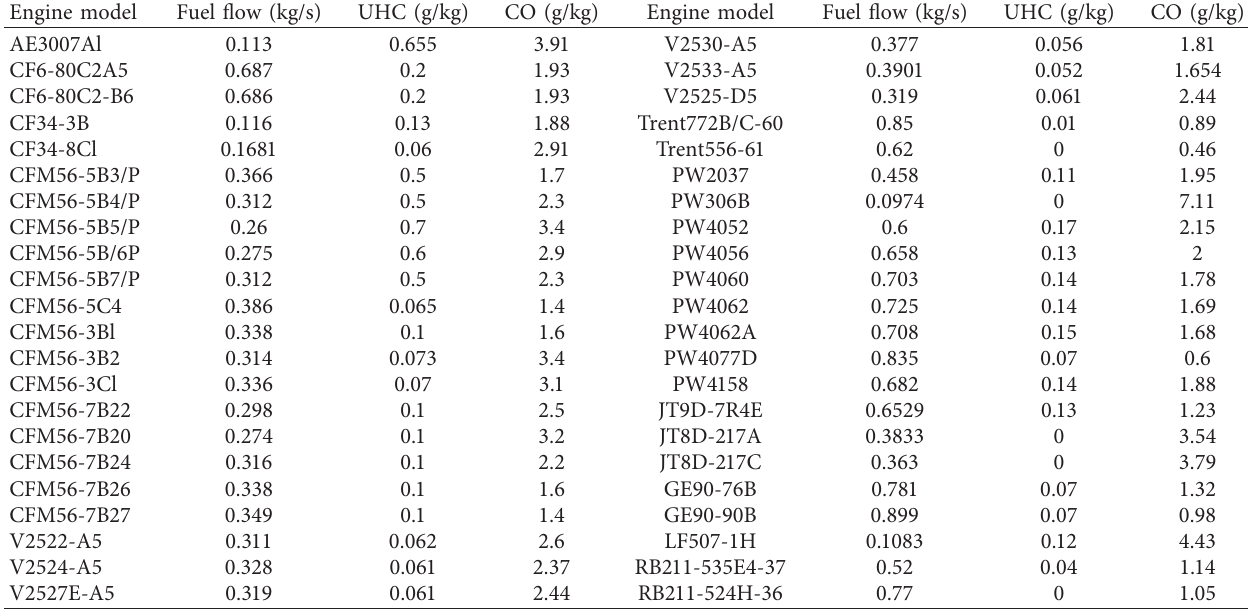
Table 4: Pollutant emission index of different engine models during approach. Engine